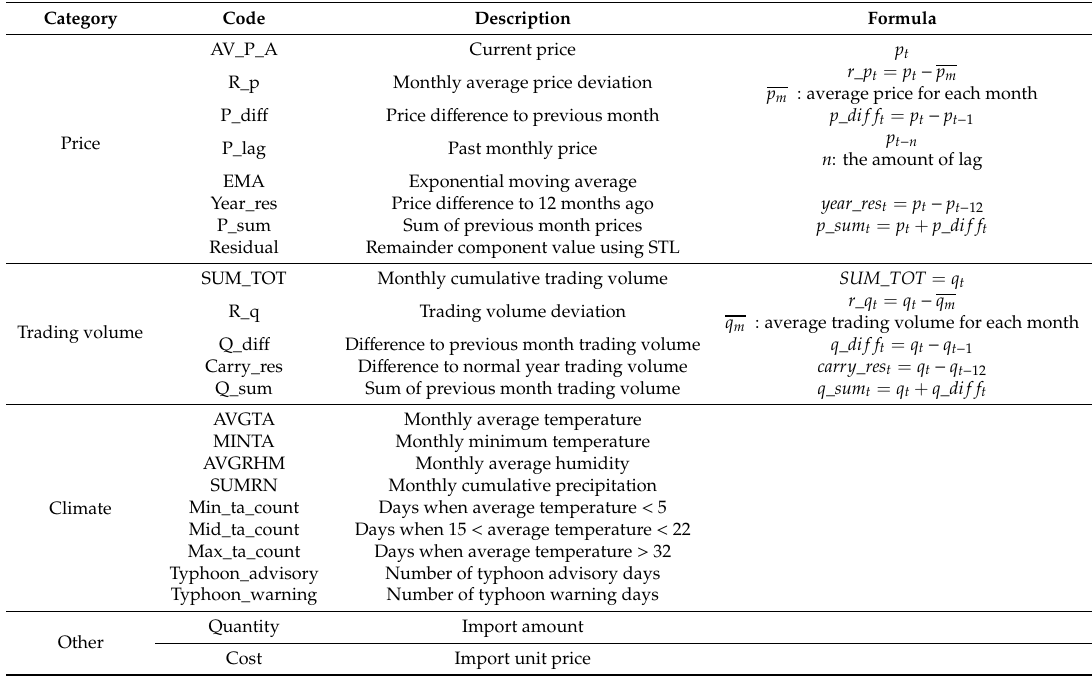
Table 4. Input variables and